Question: Sum up the contents of this chart in one sentence.
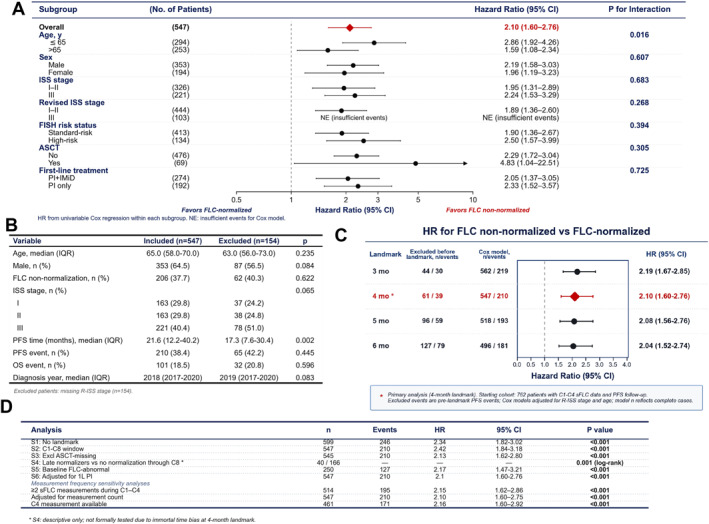
Answer: Subgroup consistency and sensitivity analyses. (A) Forest plot of hazard ratios (95% CIs) for FLC non‐normalization across prespecified subgroups. Overall HR 2.10 (1.60–2.76), n = 547. Subgroup HRs ranged from 1.59 to 4.83. For the R‐ISS subgroups, multivariable models were adjusted for age only (R‐ISS itself is constant within each subgroup); in the R‐ISS III subgroup ( n = 103, 60 events), FLC non‐normalization remained associated with inferior PFS (HR 2.59, 95% CI 1.56–4.31, p < 0.001). A nominally significant interaction was observed for age (P_interaction = 0.016). The dashed line indicates HR = 1.0. (B) Comparison of baseline characteristics between patients included in ( n = 547) and excluded from ( n = 154) the primary multivariable model, demonstrating comparable demographics and outcomes. p values calculated by chi‐squared test (categorical) or Mann–Whitney U test (continuous); no significant differences observed (all p > 0.05). (C) Landmark sensitivity analysis for FLC non‐normalization. Hazard ratios were estimated using Cox models adjusted for R‐ISS stage and age at landmark times of 3, 4, 5, and 6 months. The starting cohort consisted of 762 patients with C1‐C4 sFLC data and PFS follow‐up. The panel reports the number of patients and PFS events excluded before each landmark, the complete‐case Cox model sample size and event count, and the corresponding adjusted HRs. (D) Summary of prespecified sensitivity analyses. HRs ranged from 2.10 to 2.42 across eight formally tested analyses, including the original five (no landmark, C1–C8 window, exclusion of ASCT‐missing, restriction to baseline FLC‐abnormal, and adjustment for PI‐based therapy) and three measurement‐frequency analyses (≥ 2 sFLC measurements, adjustment for measurement count, and C4 measurement available). The S4 analysis (late normalizers vs. patients with no normalization through C8) is shown descriptively (log‐rank P only); a formal Cox comparison was not performed because this comparison is